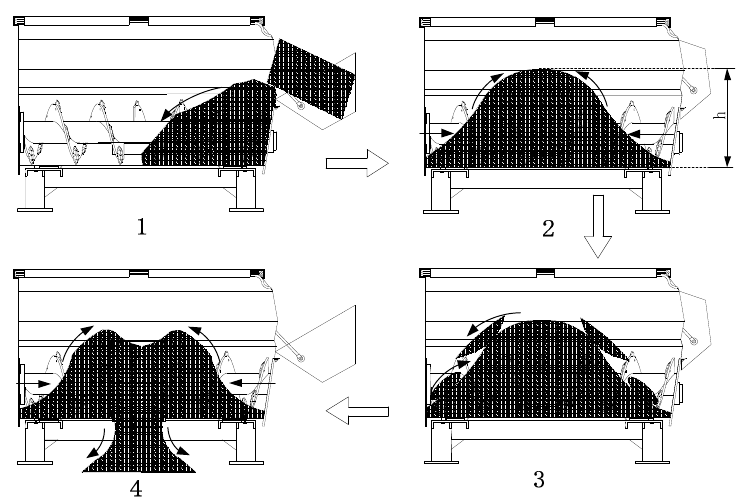
Figure 2. Schematic diagram of horizontal two ‐ axis TMR mixer.